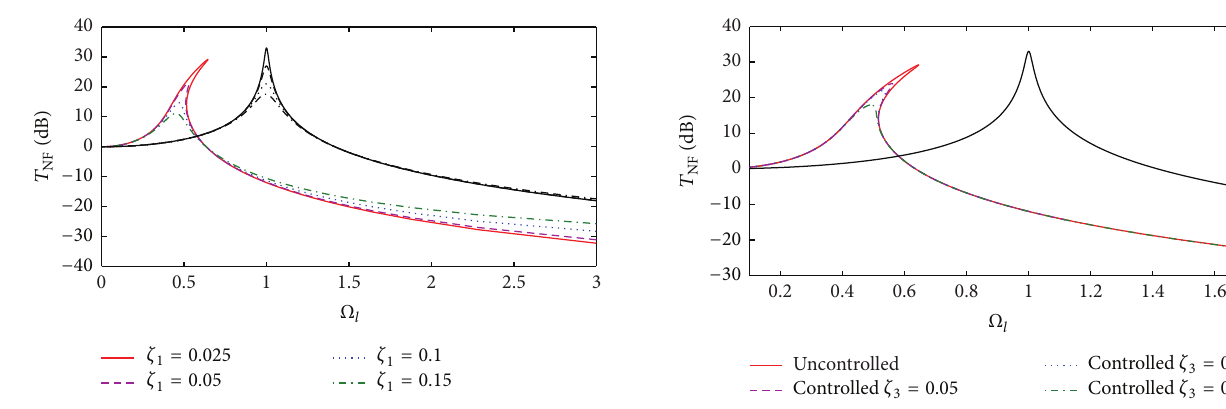
Figure 15: Force transmissibility of the uncontrolled system with different damping ratio 𝜁 1 ( 𝑓 1 = 0.05 , 𝑘 = 1 , and